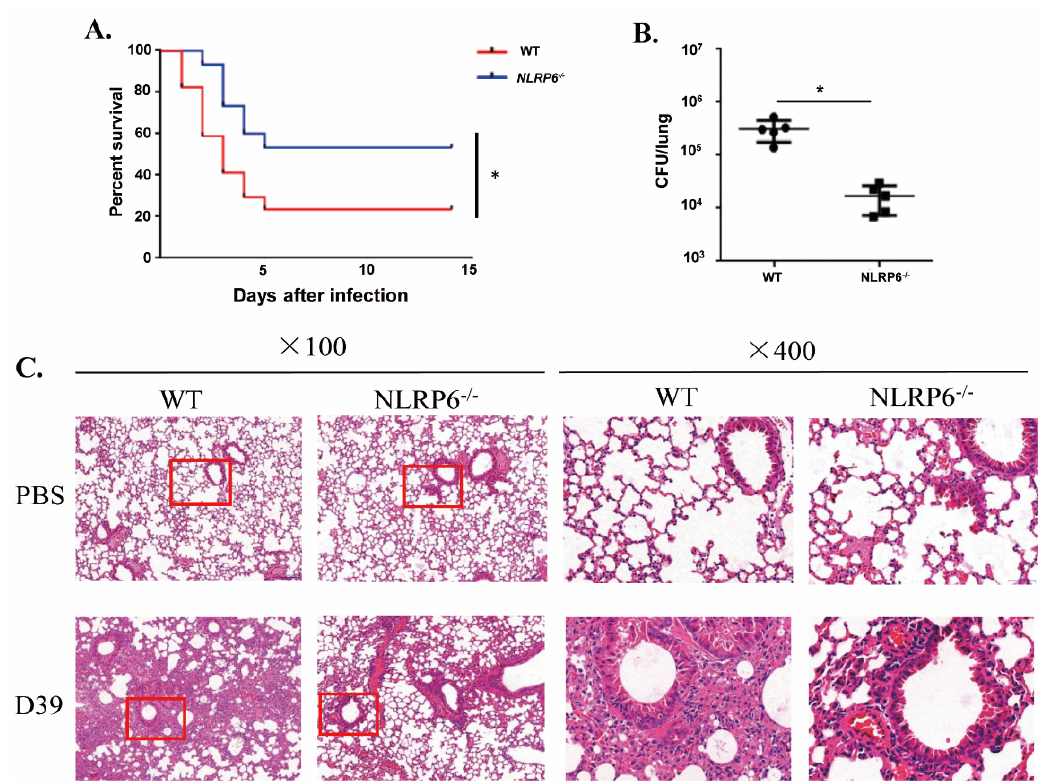
Figure 5. NLRP6 -/- mice are resistant to S. pneumoniae infection. WT and NLRP6 − / − mice were intranasally infected with S. pneumoniae (5 × 10 7 CFU). ( A ) WT ( n = 17) and NLRP6 − / − ( n = 15) mice were monitored for 14 d. ( B ) Lungs were homogenized and colony counting was performed at 48 h post infection in S. pneumoniae -infected WT ( n = 5) and NLRP6 -/- ( n = 5) mice. ( C ) The lungs were collected at 48 h post infection for hematoxylin and eosin staining (original magnification ×100 and ×400). Pictures are representative of three mice from each group of mice. Tests for statistical significance were performed using one-way ANOVA followed by the Bonferroni test (* p < 0.05).